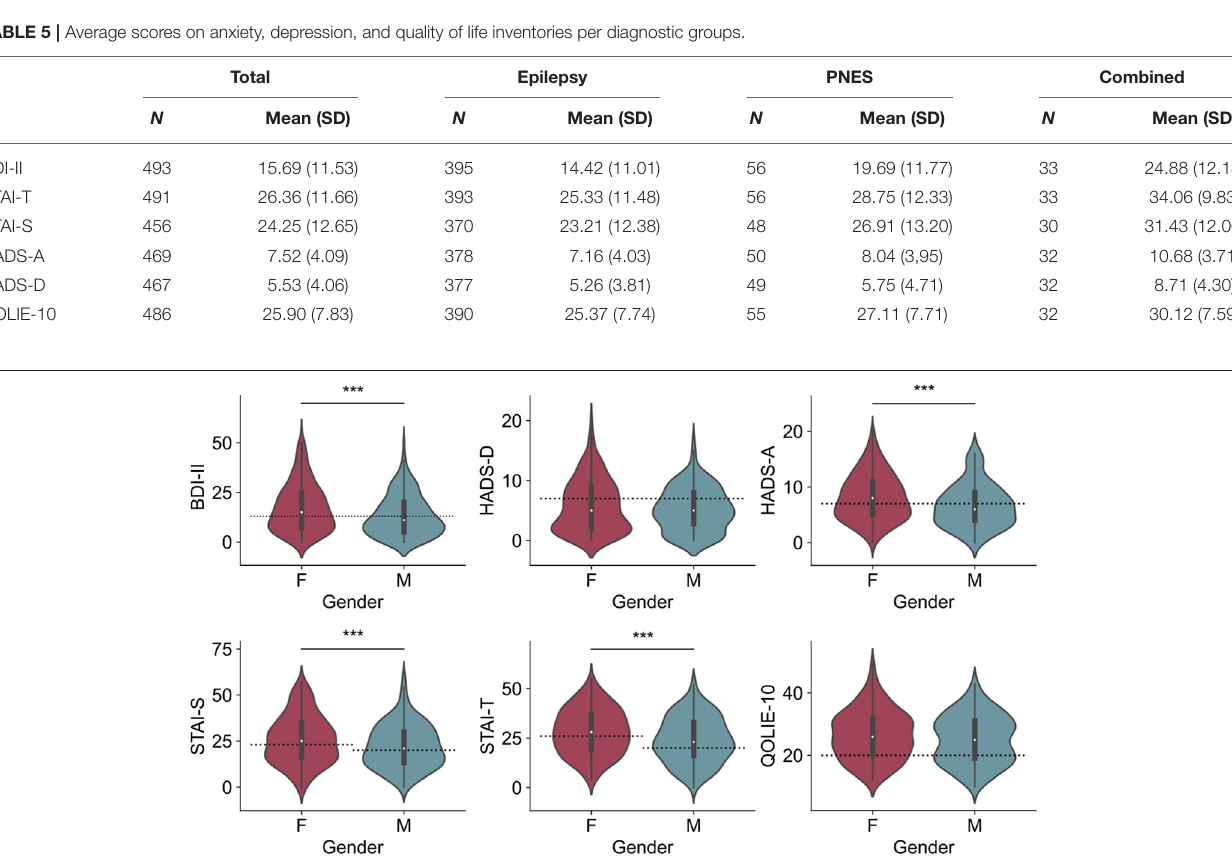
FIGURE 1 | Median of scores on the inventory scales according to gender. BDI, HADS-A, STAI-S, and STAI-T scores were significantly higher in female patients. *** p < 0.01.